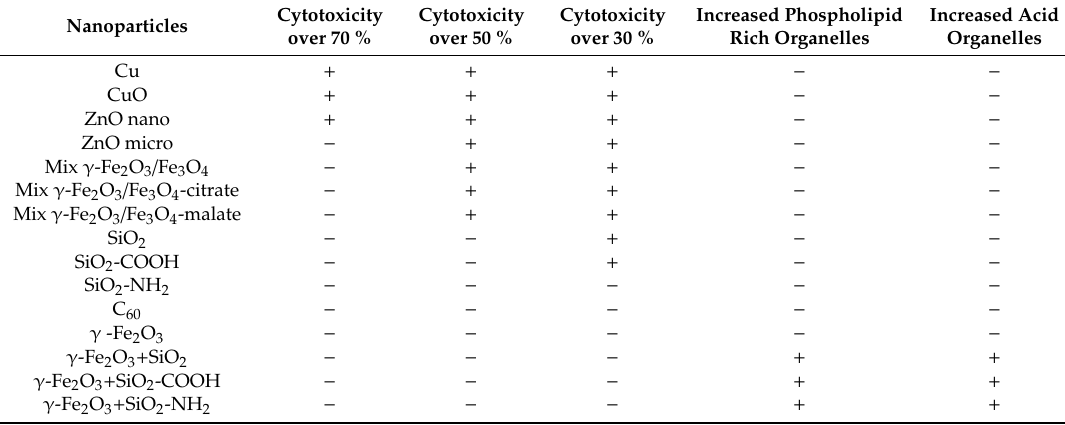
Table 2. Comparison of measured biological e ff ects for selected nanoparticles (NPs). Cytotoxicity of NPs at 50 µ g · mL − 1 was measured by the MTT assay after a 24-h exposure of A549 cells. Cellular quantity of phospholipid rich organelles and cellular load of acid organelles were microscopically evaluated in LipidTOX or neutral red stained A549 cells after a 48-h treatment with 50 µ g · mL − 1 NPs. For particles that proved to be highly cytotoxic at 50 µ g · mL − 1 (Cu, CuO, ZnO nano, ZnO micro, Mix / Fe / Fe / Fe γ -Fe γ -Fe γ -Fe 2 O 3 3 O 4 , Mix 2 O 3 3 O 4 -citrate, Mix 2 O 3 3 O 4 -malate), we performed phospholipid